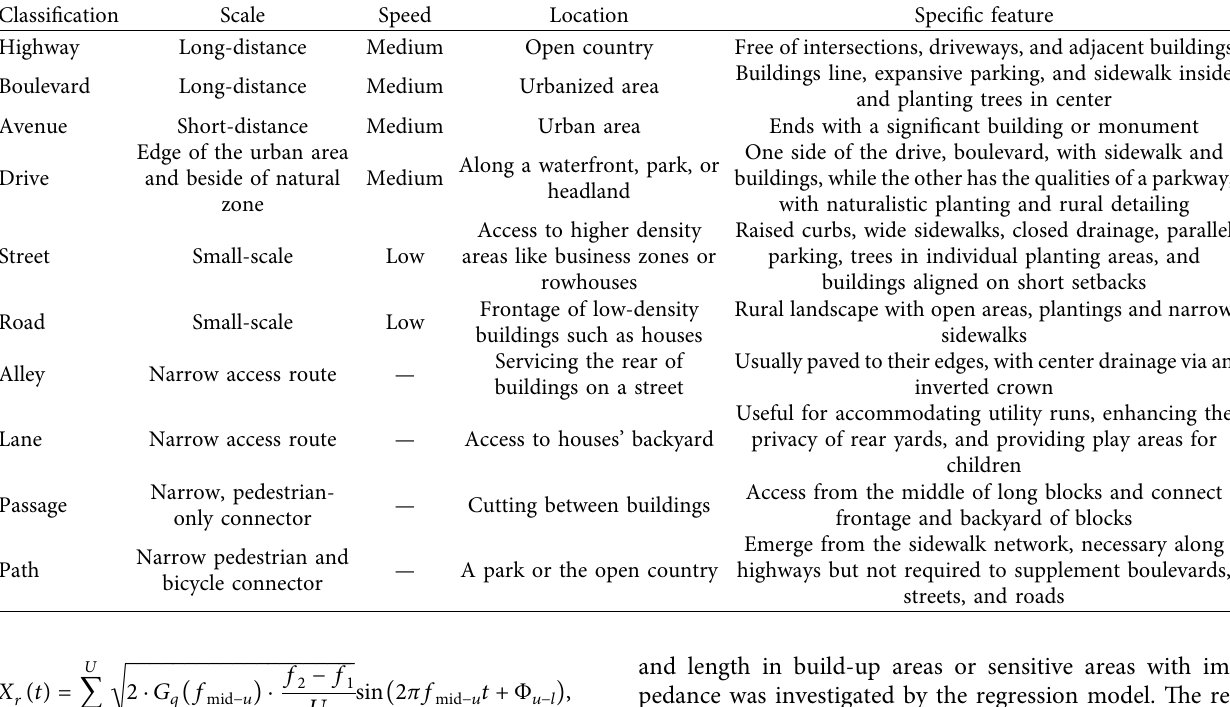
Table 1: AIA street classification system